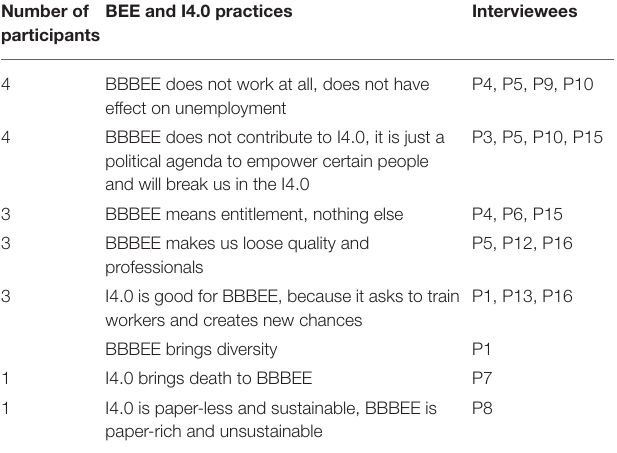
TABLE 4 | BBBEE and I4.0